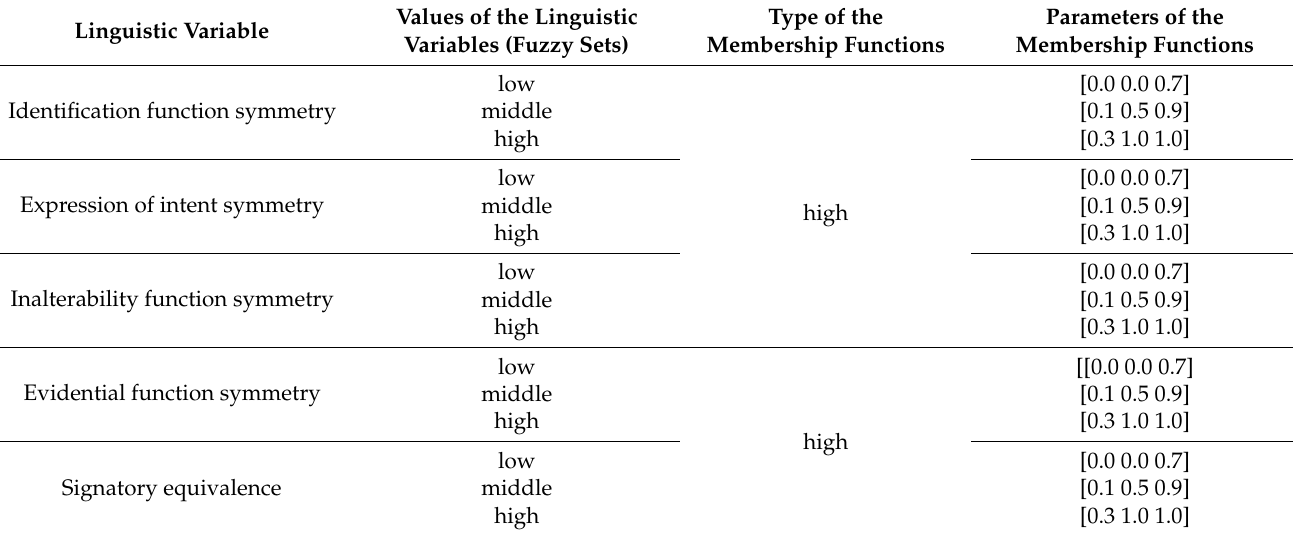
Table 4. Parameters of fuzzy inference system. Values of the Linguistic Variable